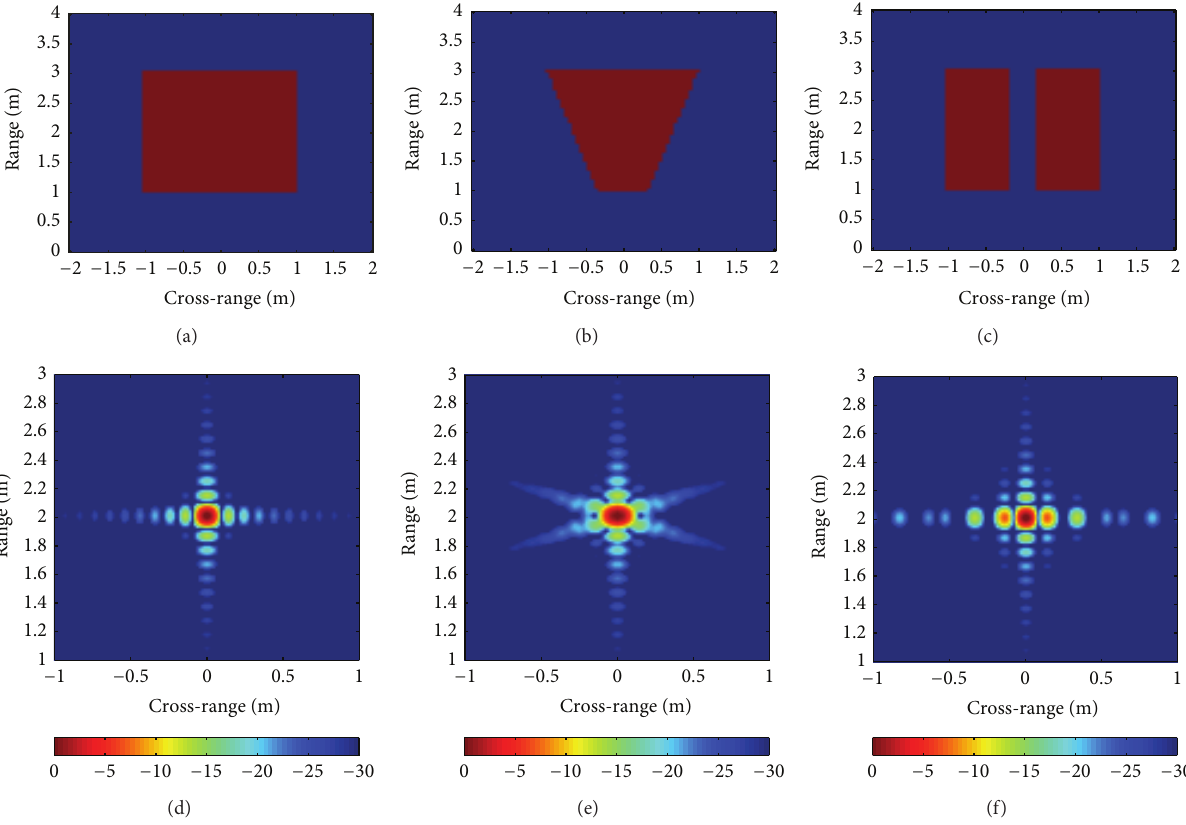
Figure 4: Three different support areas of the spatial spectrum and the corresponding target images: (a) rectangle, (b) isosceles trapezoid, (c) gapped rectangle, (d) target image for Figure 4(a), (e) target image for Figure 4(b), and (f) target image for Figure 4(c).